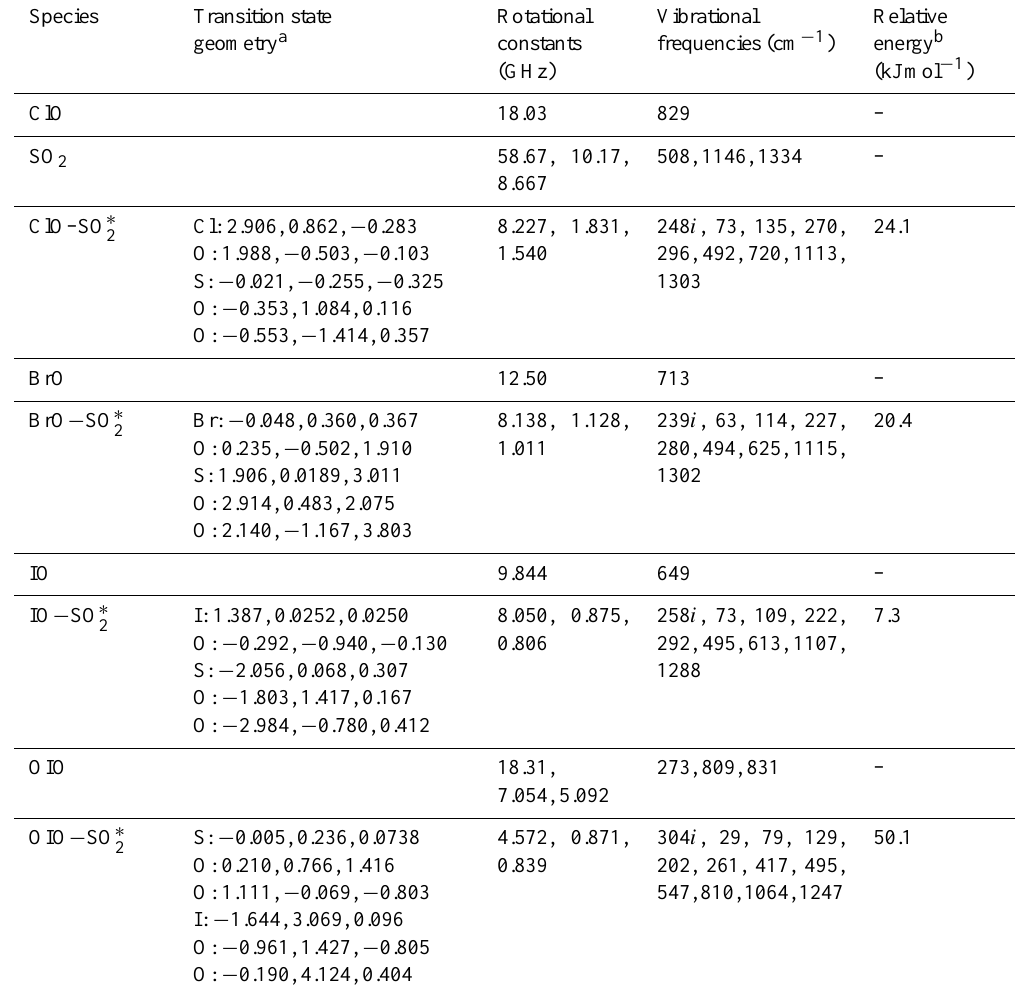
Table 1. Molecular parameters and energies for transition state theory calculations (see text for theoretical methods). The symbol ∗ indicates a transition